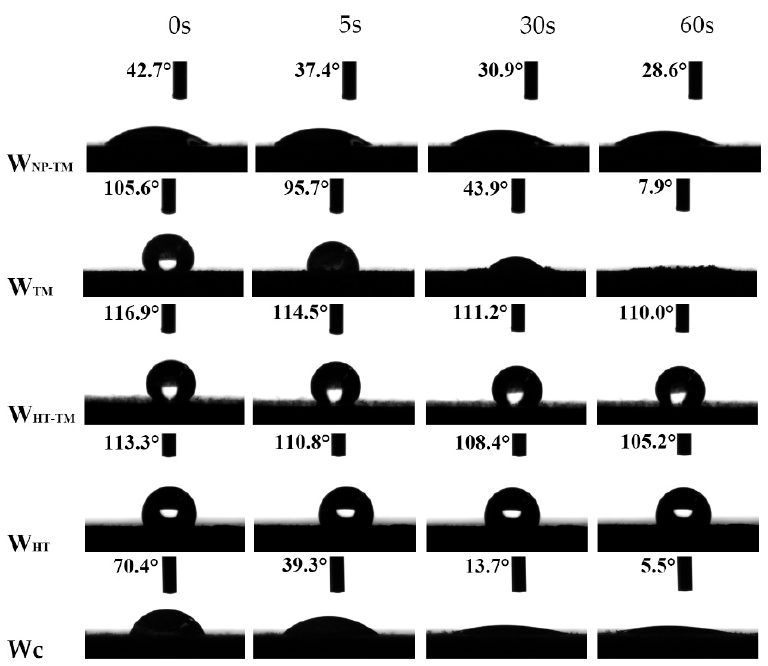
Figure 1. Images of water droplets on surface of untreated and treated poplar.